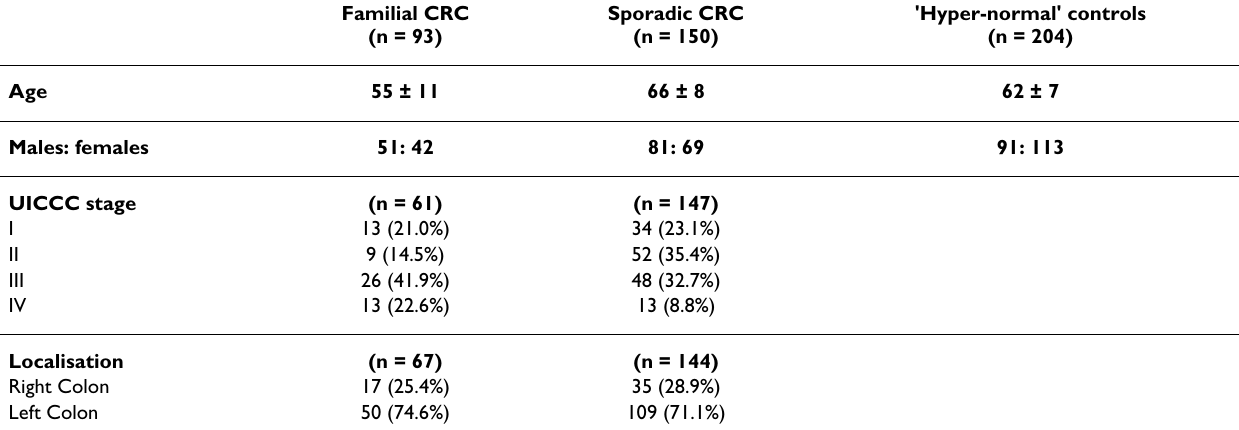
Table 1: Clinical characteristics of familial CRC, sporadic CRC patients and 'hyper-normal'